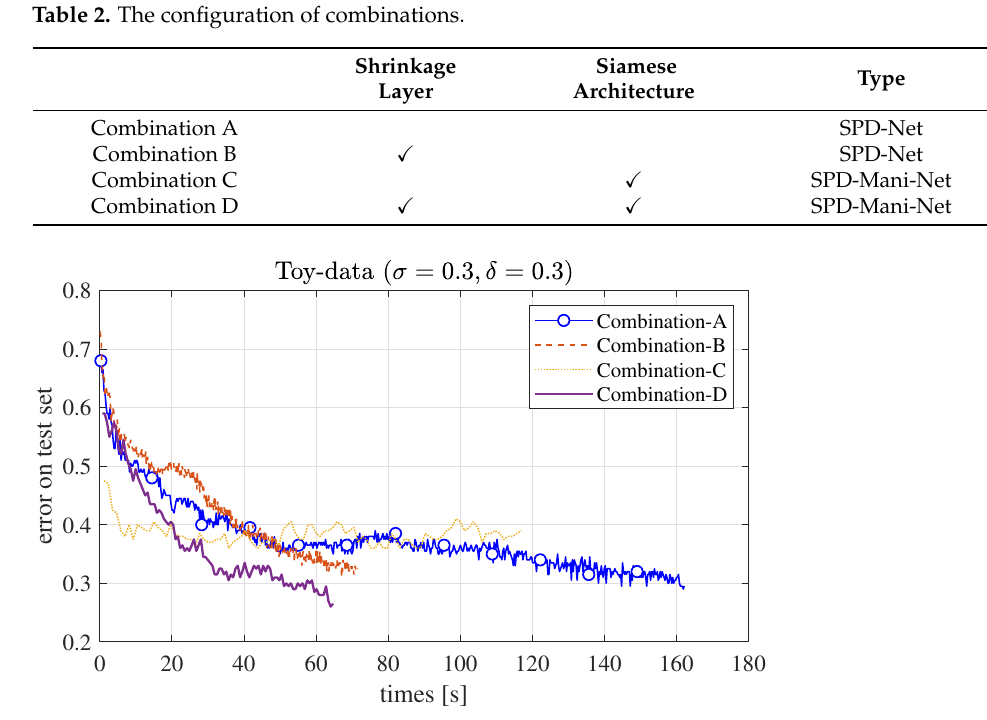
Figure 5. Comparison results of the four combination schemes in terms of time and